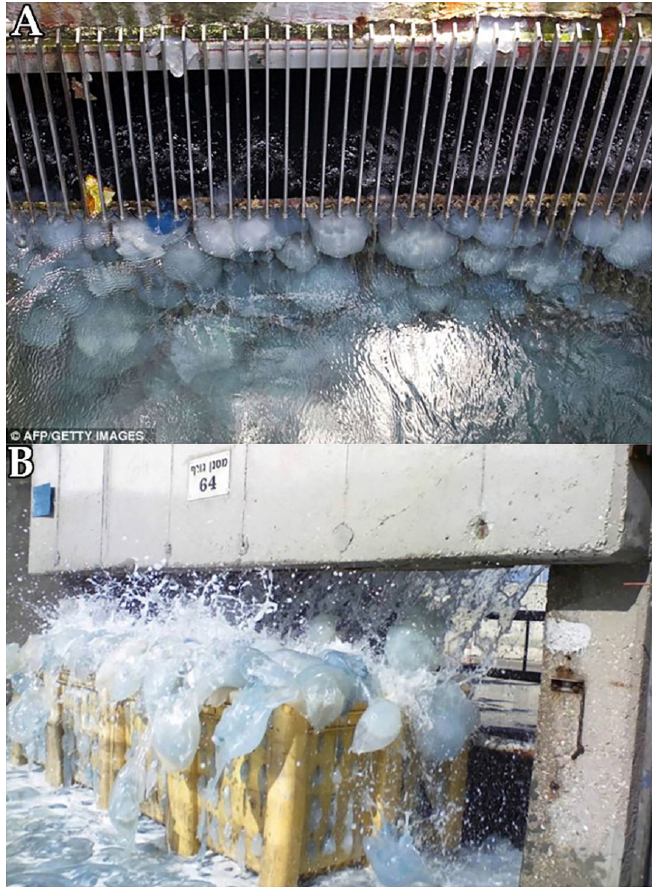
Figure 18. Nomadic jellyfish clogging the sweeping filter of the intake cooling water system ( A ) in Orot Rabin electric power plant in Hadera (for location see Figure 2) and overflowing the collecting containers ( B ) (photographs by Avi Algazi).